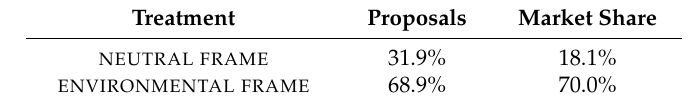
Table 4. Share of green (A) goods in proposals and purchases.